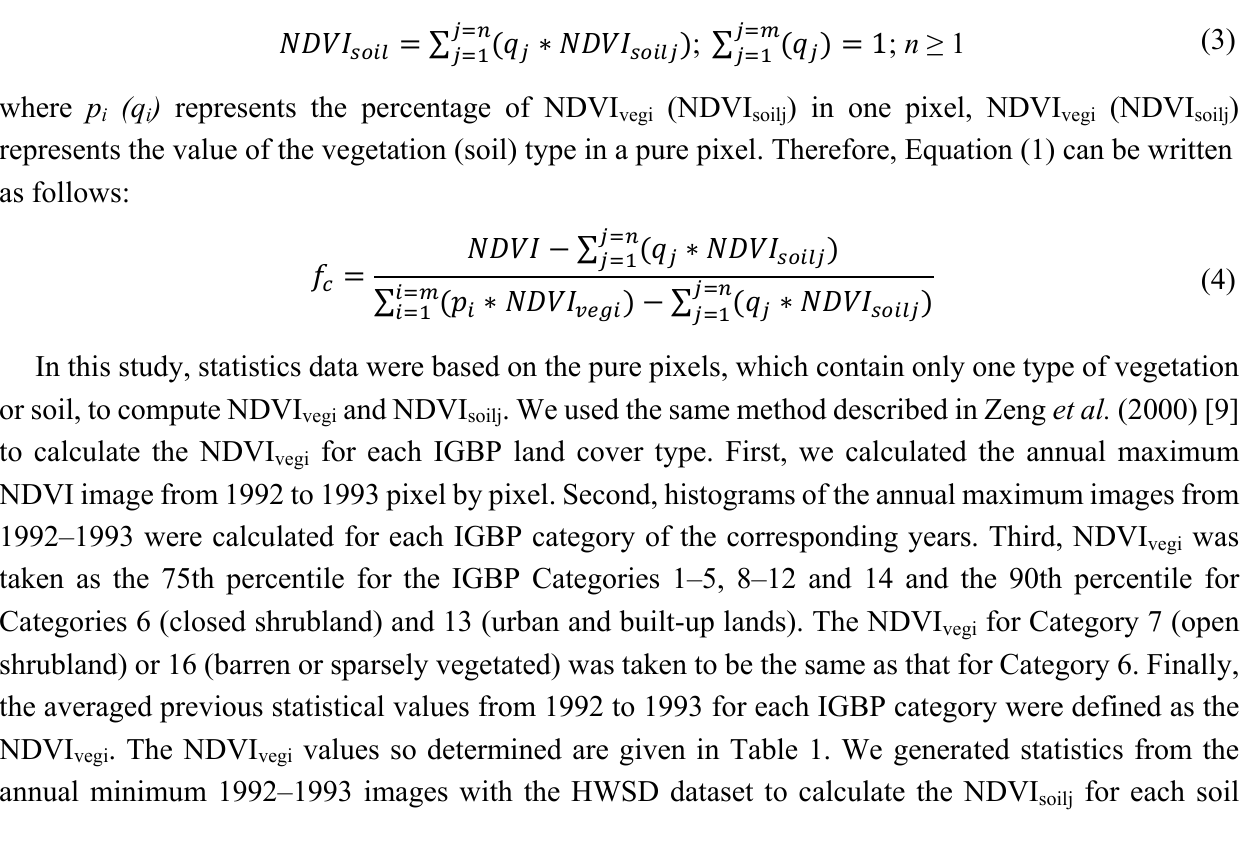
Table 1. Values of GIMMS NDVI